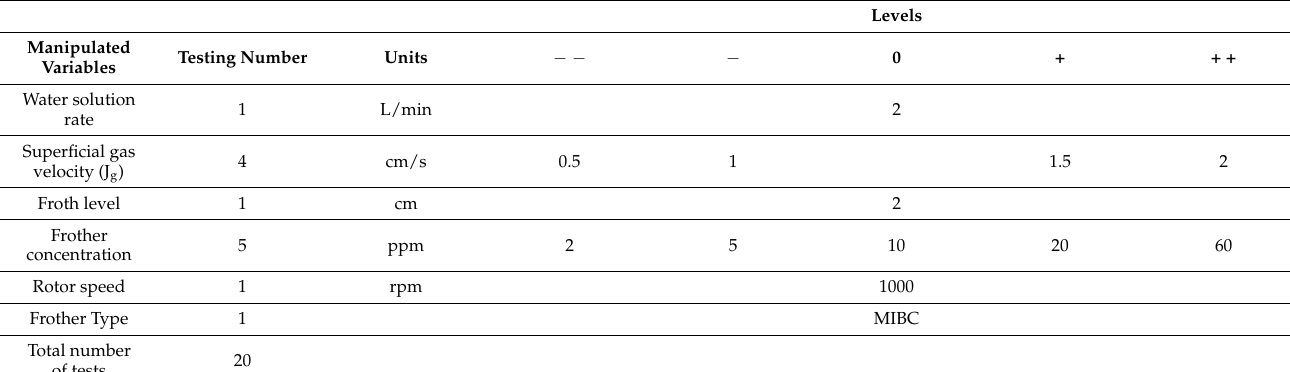
Figure 2. Gas dispersion testing rig. ( a ) Illustration, ( b ) photograph of the actual setup. Table 1. Experimental conditions for gas dispersion